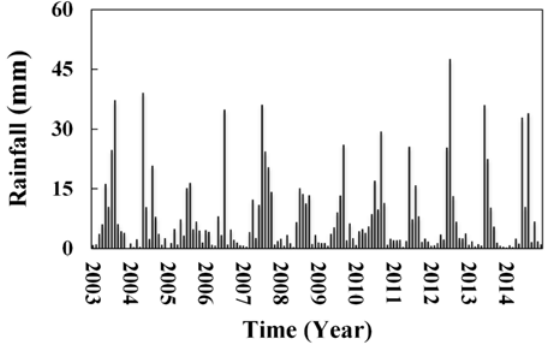
Figure 7. Monthly rainfall from 2003 to 2014 in the Beishan area.